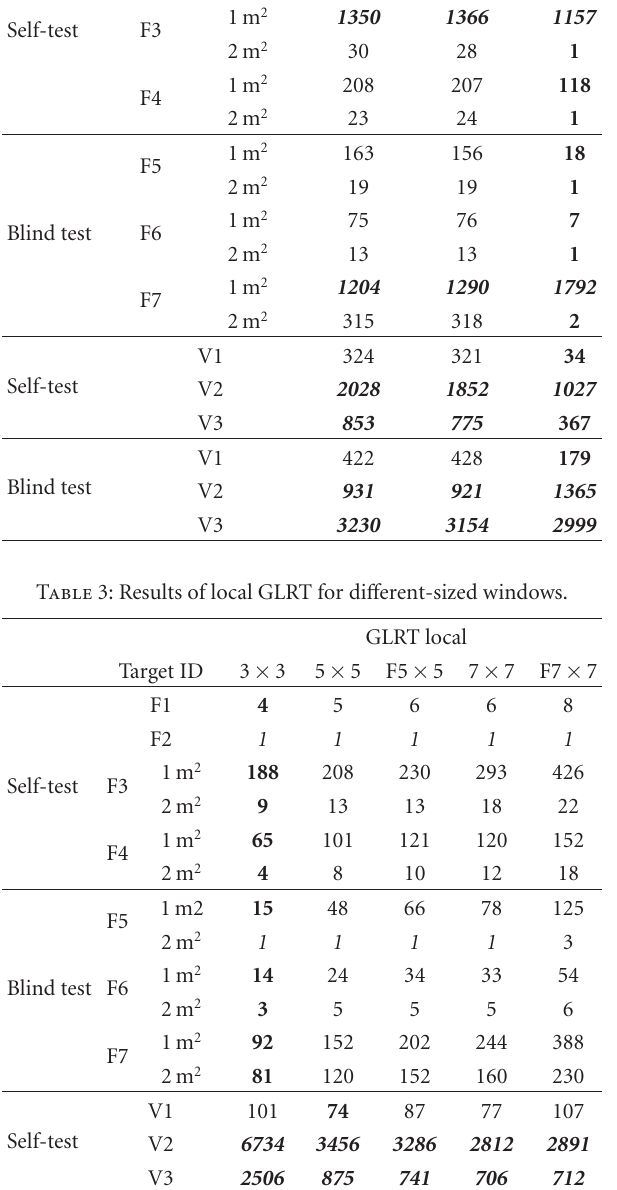
Table 4: Results of local ACE for di ff erent-sized windows.